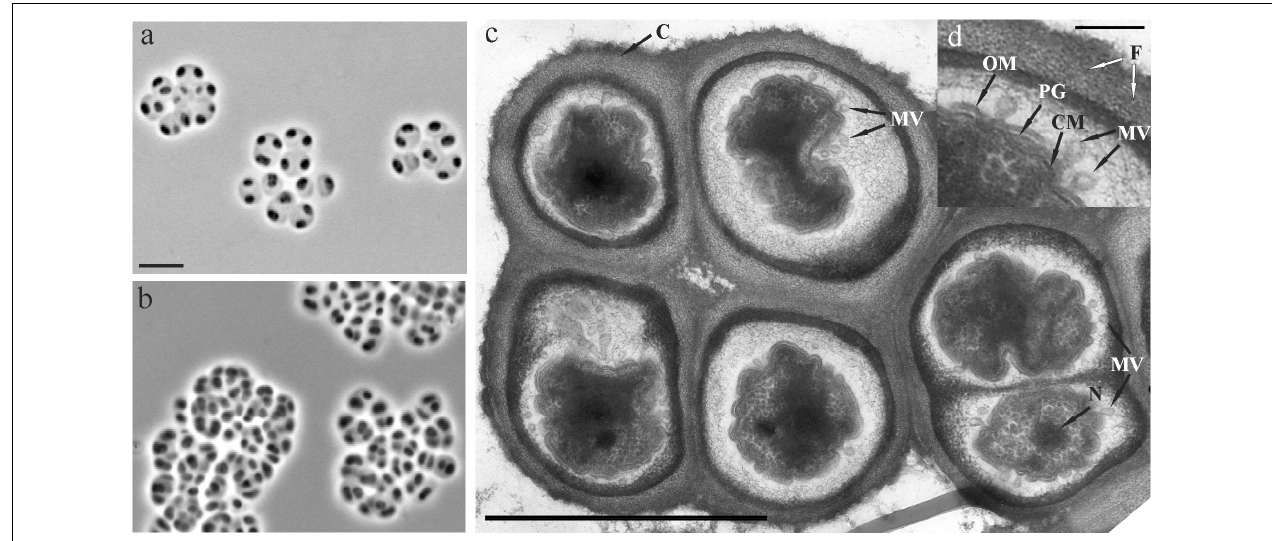
FIGURE 2 | (a,b) Phase-contrast images of cells of strain SBC82 T grown for 7 days (a) and 2 weeks (b) in the liquid medium MA supplemented with glucose (a) and xylan (b) as carbon sources. (c) Electron micrograph of an ultrathin section of a cell aggregate from a glucose-grown culture. (d) Enlarged view of outer membrane vesicles formed by invaginations of cytoplasmic membrane. CM, cytoplasmic membrane; OM, outer membrane; PG, peptidoglycan layer; MV, membrane vesicles; N, nucleoid; C, saccular chambers; F, fibril-like structures. Bars, 5 µ m (a,b) , 1 µ m (c) , and 0.1 µ m (d)